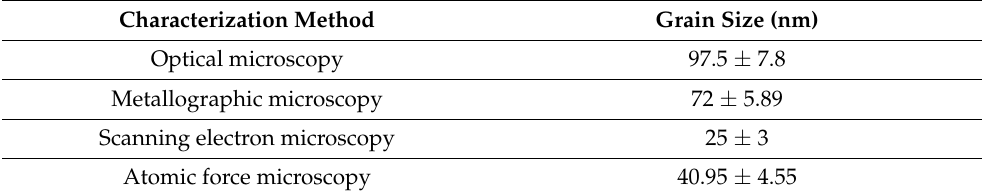
Table 1. Grain size of DIO-NPs coatings obtained from different characterization methods .